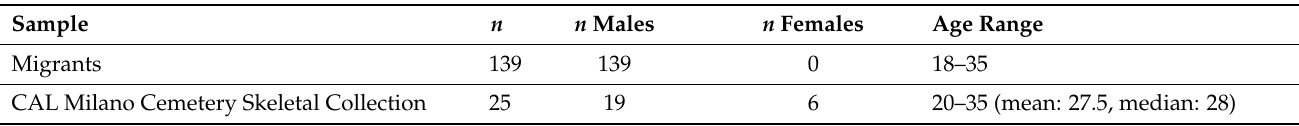
Table 1. Details of the study